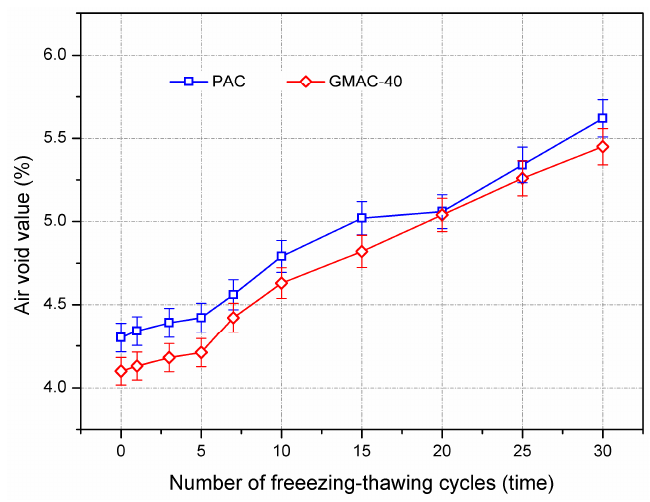
Figure 7. Variation of air void of asphalt mixtures after freezing–thawing cycles.